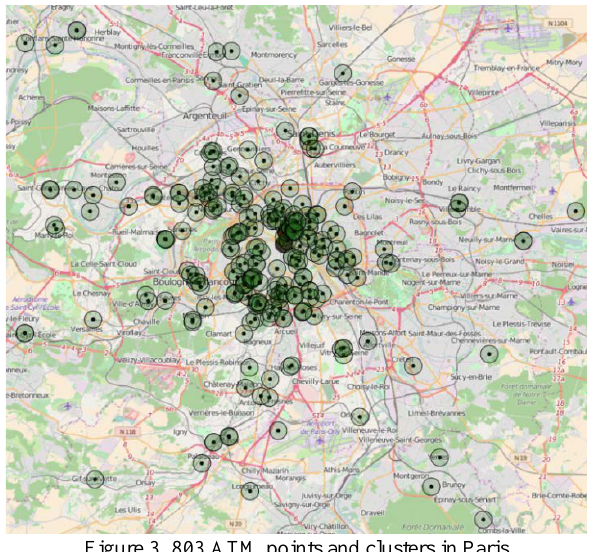
Figure 3. 803 ATM points and clusters in Paris